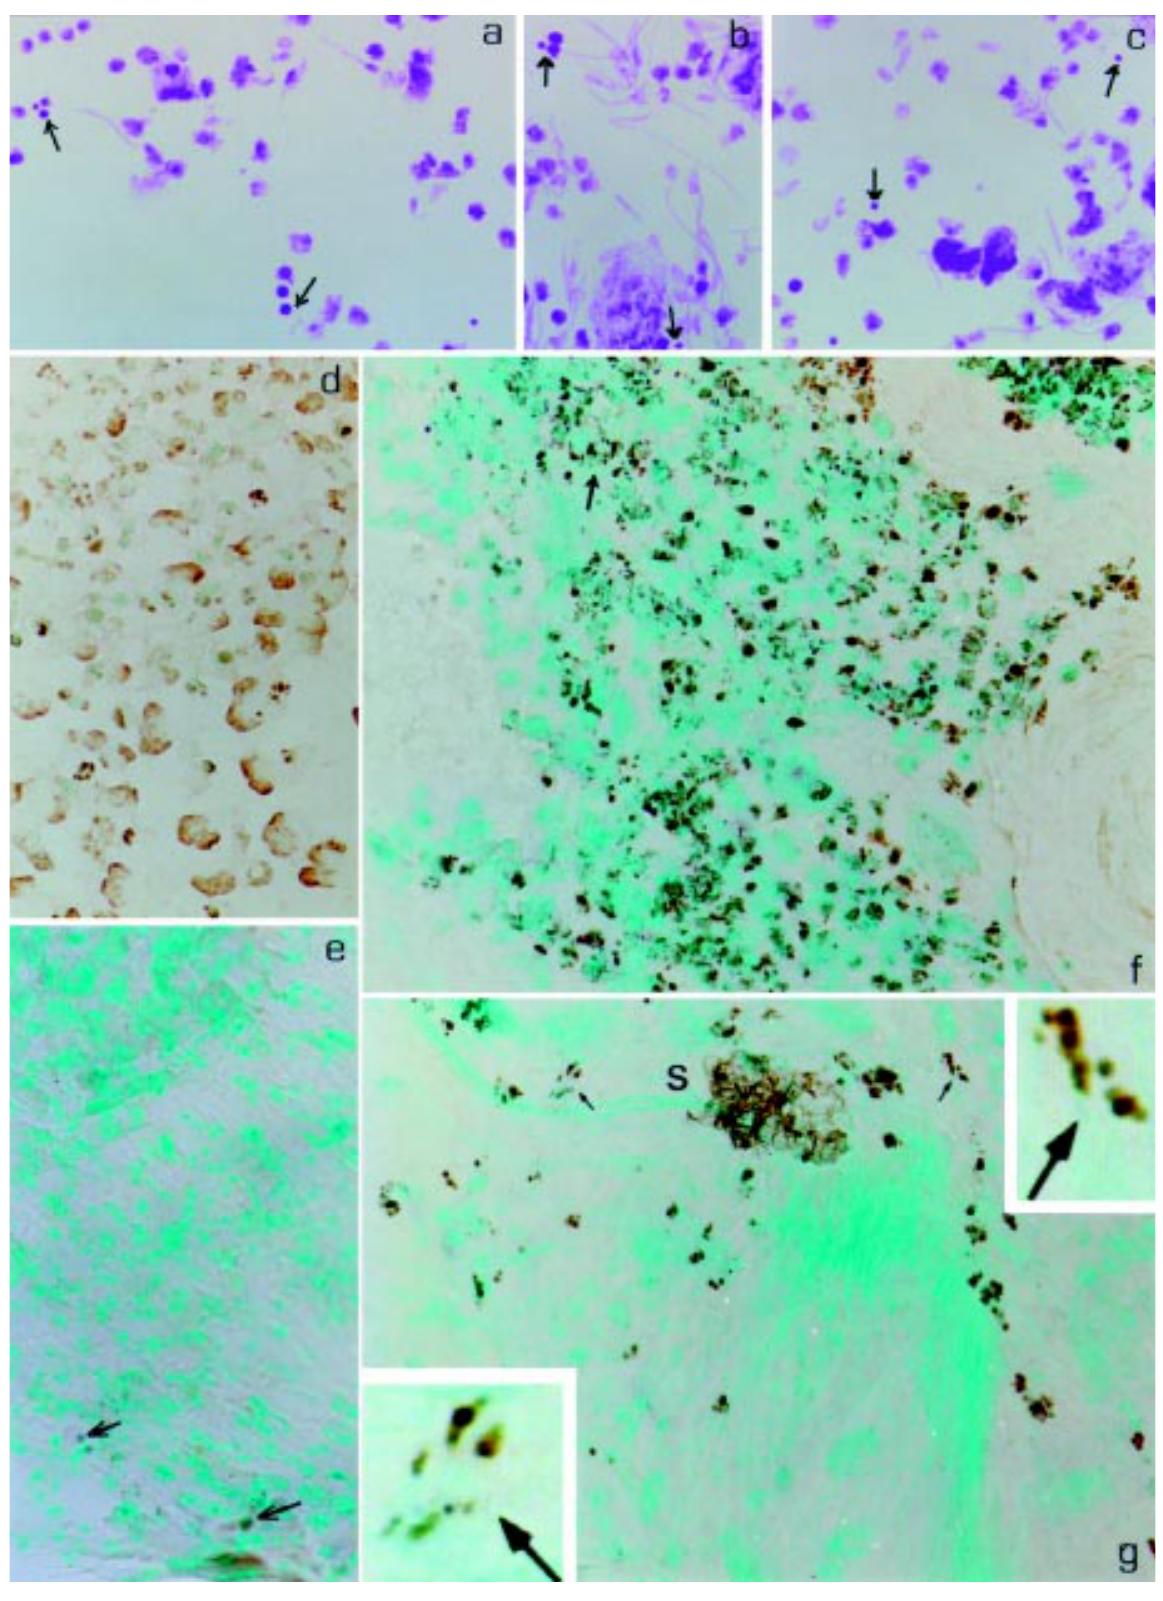
Figure 1 - Male germ line cells of T. infestans 7 ( a, b, f ) and 30 ( c, g ) days after exposure of the insects to short-duration heat shock. a-c , Feulgen staining; d-g , TUNEL assay; d , control V79 cells showing a positive TUNEL response; e , control specimen not exposed to heat shock. The arrows show apoptotic nuclei/vesicles (panels a-c) and a positive TUNEL response (panels e-g ). Details of the reaction in chromosomes are shown in the insets of panel g . 400X; insets,